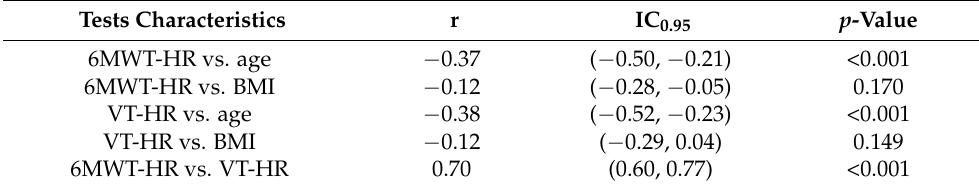
Table 3. Correlations between physiological parameters and HRs at baseline ( N = 138) and between the HRs of the CPET and 6MWT.